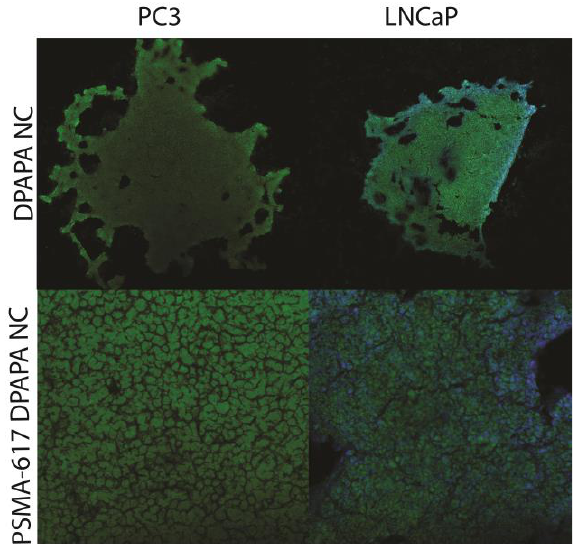
Figure 9. Images of C-Fe 3 O 4 -SiO 2 -HPG-NH 2 -DPAPA and C-Fe 3 O 4 -SiO 2 -HPG-NH 2 -DPAPA-PSMA- 617 applied to PC-3 and LNCaP three-dimensional cell lines (10× objective magnification taken with blue and red filter).